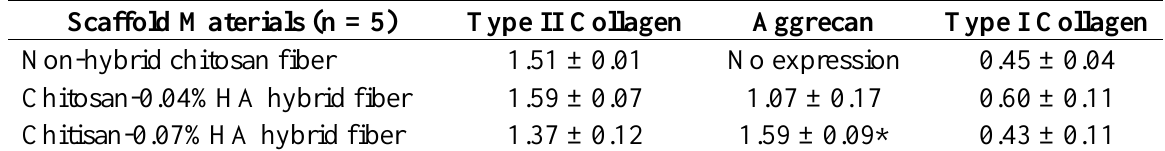
Mean ± standard deviation. Values are mean normalized ratio (experimental integrated density/GAPDH integrated density) of mRNA. *p < 0.05 vs. chitosan-0.04% HA hybrid polymer